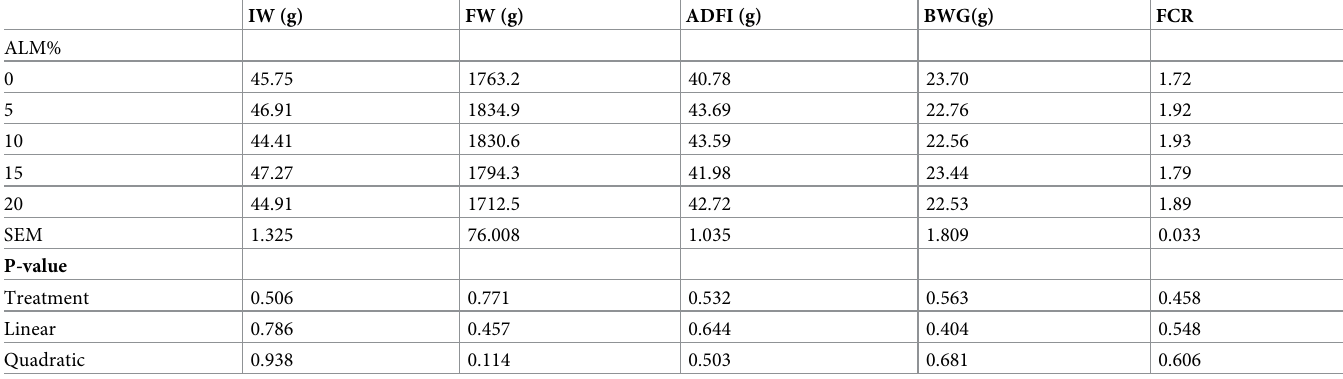
Table 4. Effect of amaranth inclusion leaf meal on initial weight (IW), final weight (FW) feed intake (ADFI), body weight gain (BWG) and feed conversion ratio (FCR) of Ross 308 broiler